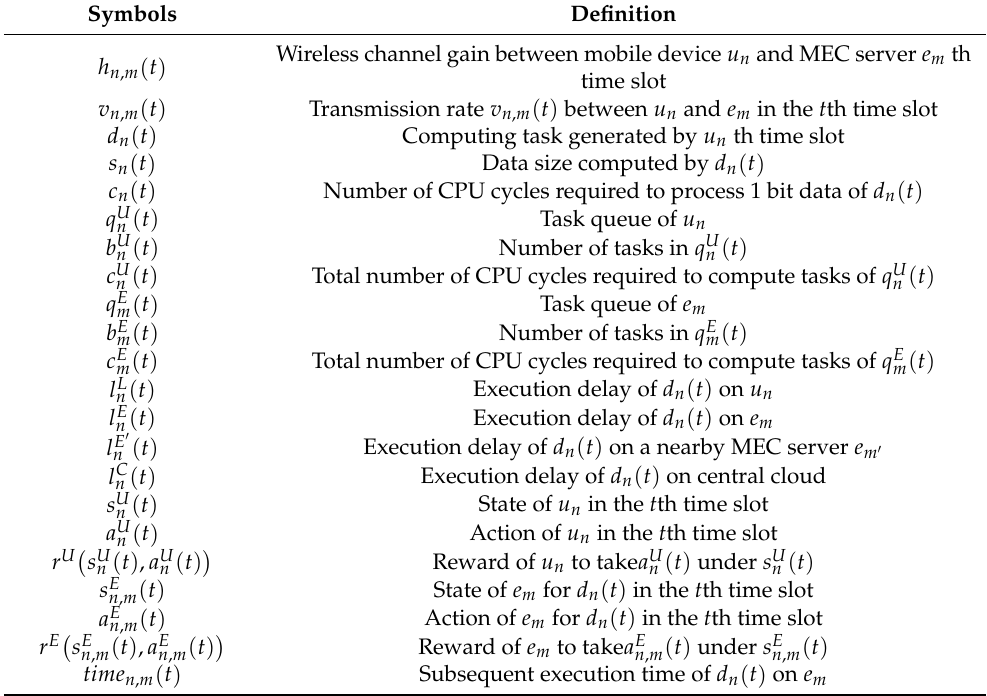
Table 2. Main used notations.